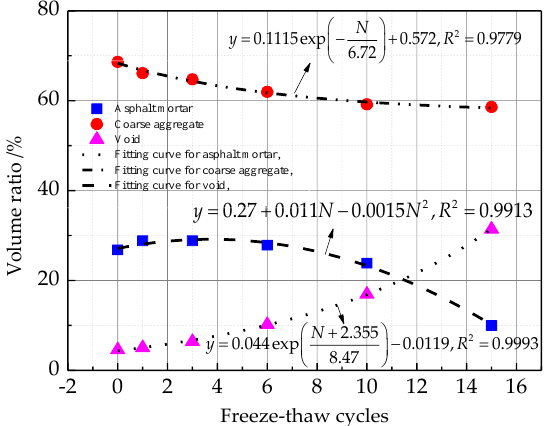
Figure 7. Three-dimensional reconstruction of components of AC-13 specimen.